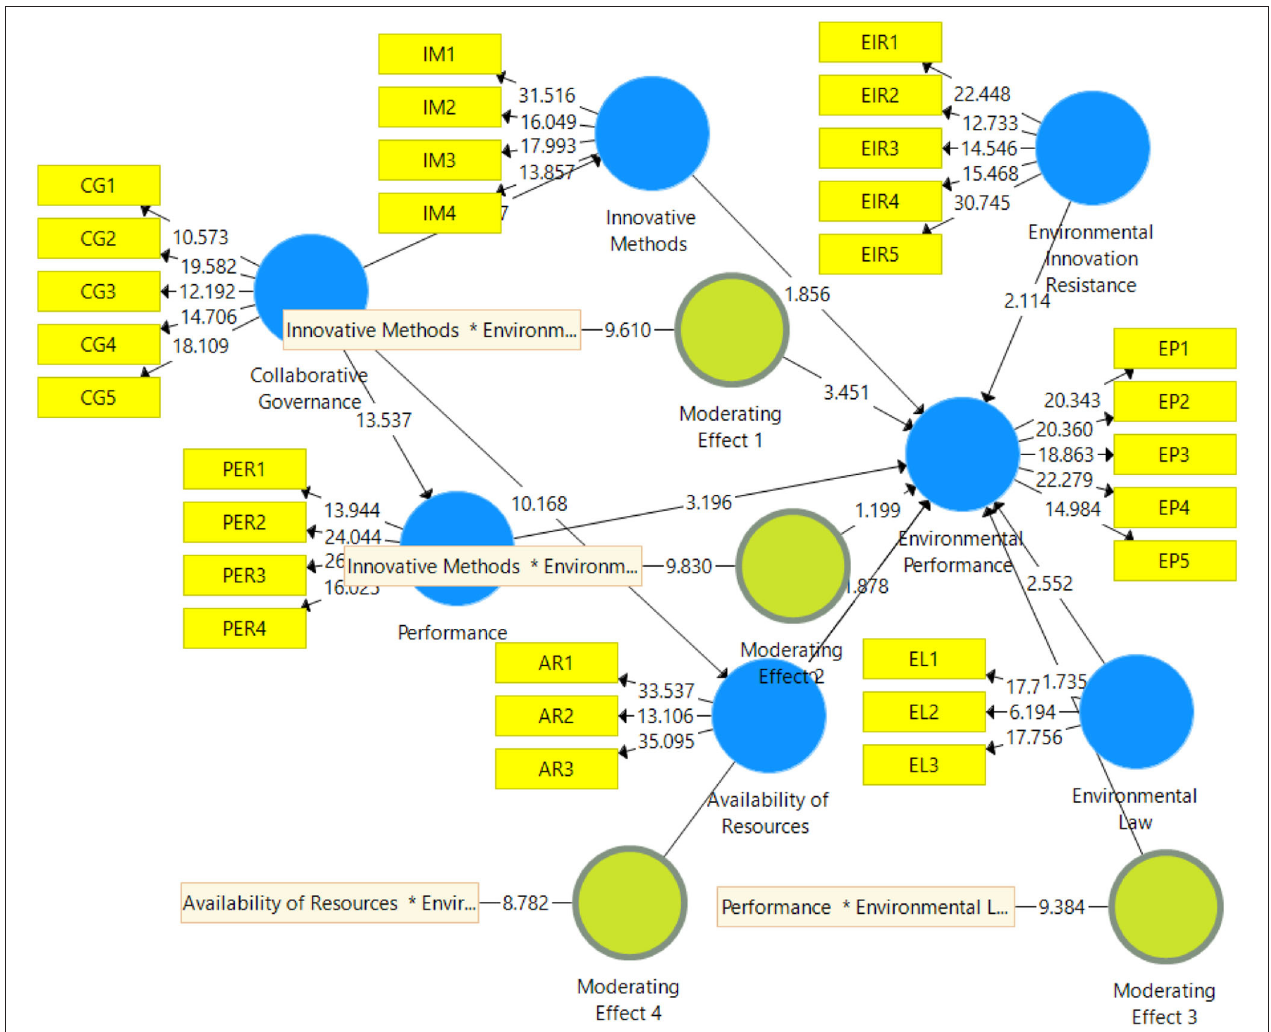
FIGURE 3 | Structural Model. CG, Collaborative Governance; IM, Innovative Methods; PER, Performance; AR, Availability Of Resources; EIR, Environmental Innovation Resistance; EL, Environmental Law; EP, Environmental